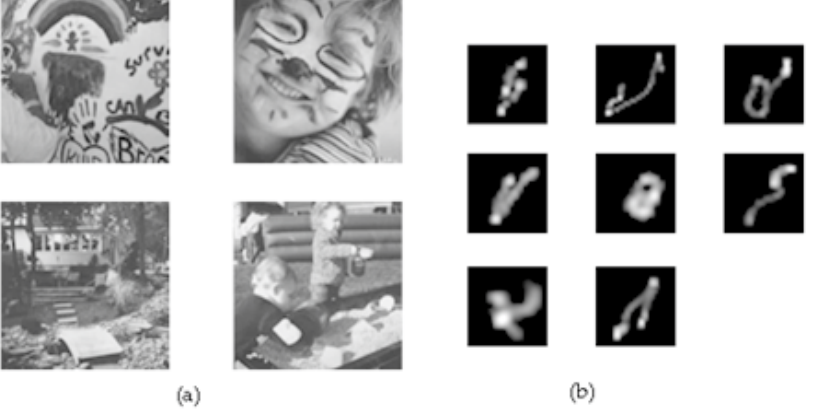
Figure 4. The Levin library; ( a ) the original images from the Levin library; ( b ) kernels.